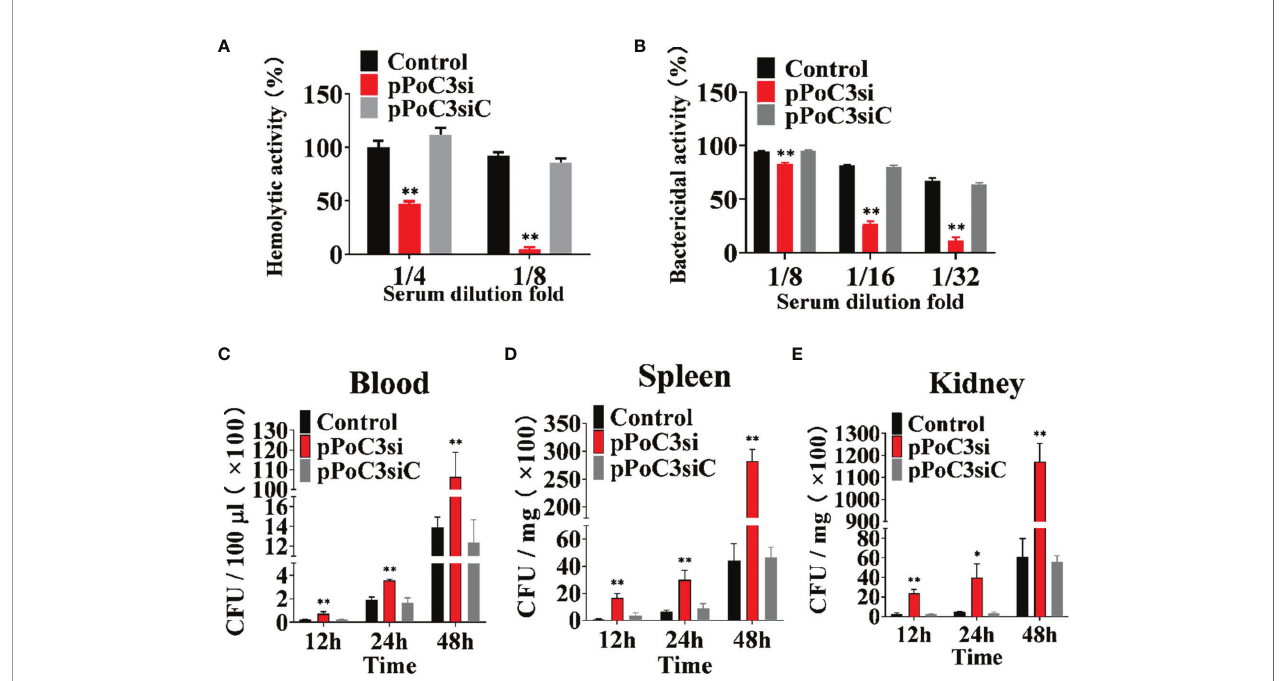
FIGURE 6 | Effect of PoC3 knockdown on complement activation and bacterial infection. (A, B) Effect of PoC3 knockdown on hemolytic activity and bactericidal activity. Serum from Japanese fl ounder treated with pPoC3si, pPoC3siC, or PBS (control) was serially diluted and incubated with rabbit red blood cells (A) and Escherichia coli (B) , respectively. At 1 h after incubation, the hemolytic (A) and bactericidal (B) activities of the serum were determined. (C – E) Effect of PoC3 knockdown on bacterial infection. Japanese fl ounder pre-administered with or without (control) pPoC3si or pPoC3siC were infected with Edwardsiella tarda , and bacterial numbers in blood (C) , spleen (D) and kidney (E) were determined at various time points. Data are shown as means ± SEM (N = 3). N, the number of times the experiment was performed. *P < 0.05, **P <